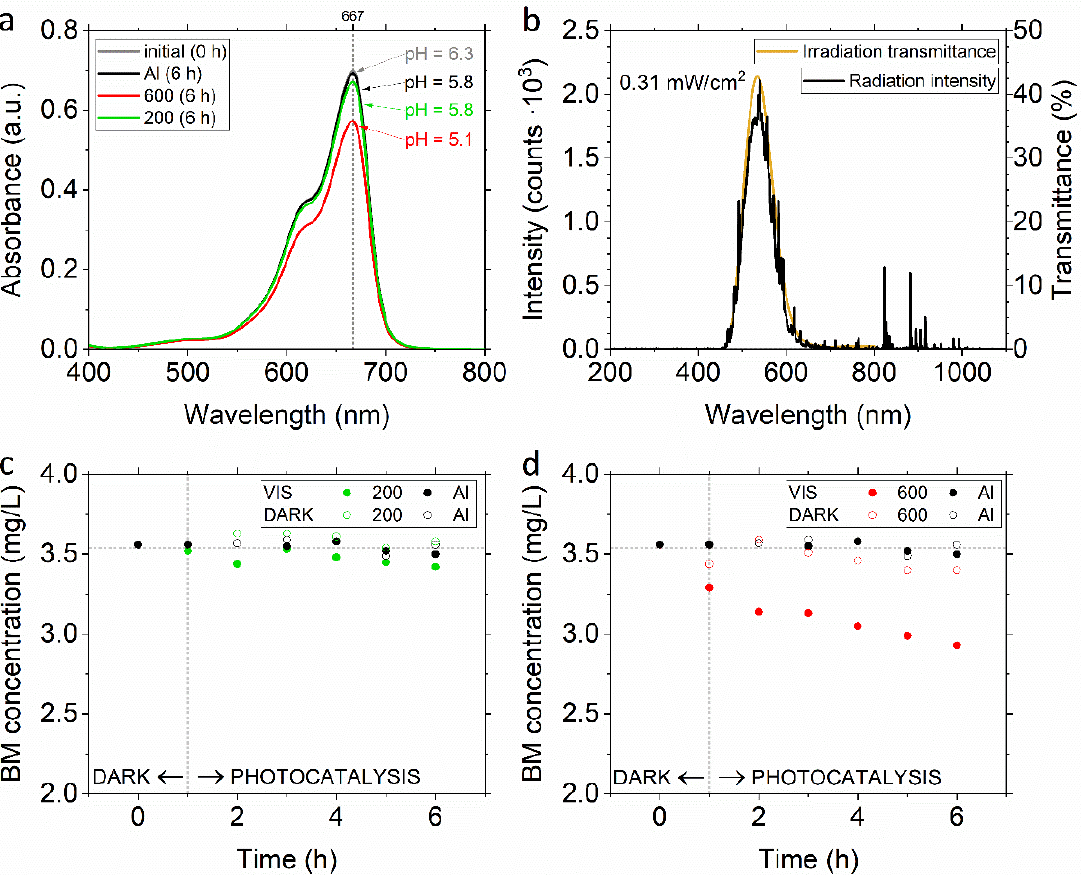
Figure 7. ( a ) Absorption spectra and ( c , d ) kinetics of methylene blue (MB) degradation in the presence of sample 200 (green) and 600 (red) and inactive Al substrate (black) under visible light irradiation from Xe lamp equipped with the UV cut-off filter ( b ) with its characteristics: measured radiation intensity (black), irradiation transmittance through the UV cut-off filter measured spectrophotometrically (yellow).